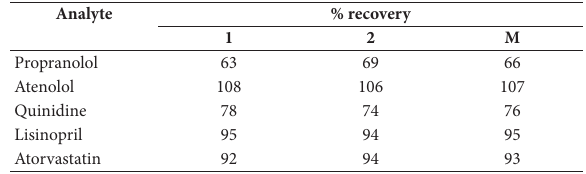
Table 8. Permeability coefficient (Papp) of atorvastatin, lisino- pril and three reference compounds through the monolayer of Caco-2 cells in the apical-basolateral direction.